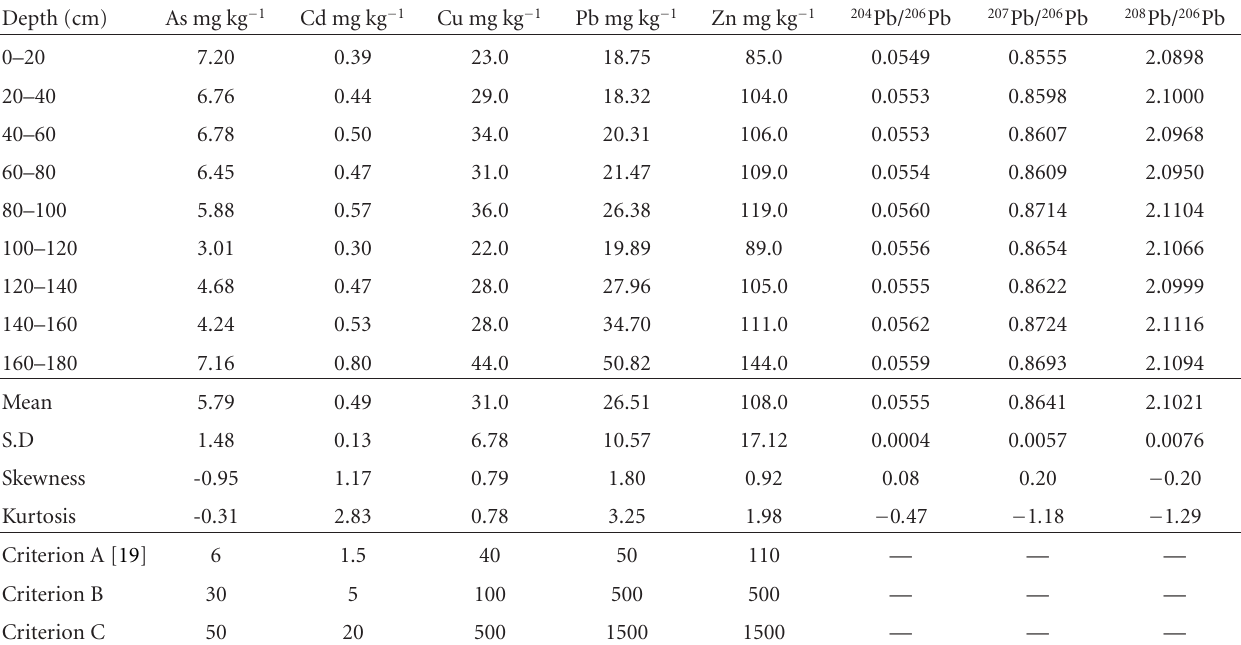
Table 3: Lead and heavy metal concentrations and Pb isotopic compositions in soil profile at Windsor site (STE-1). Depth